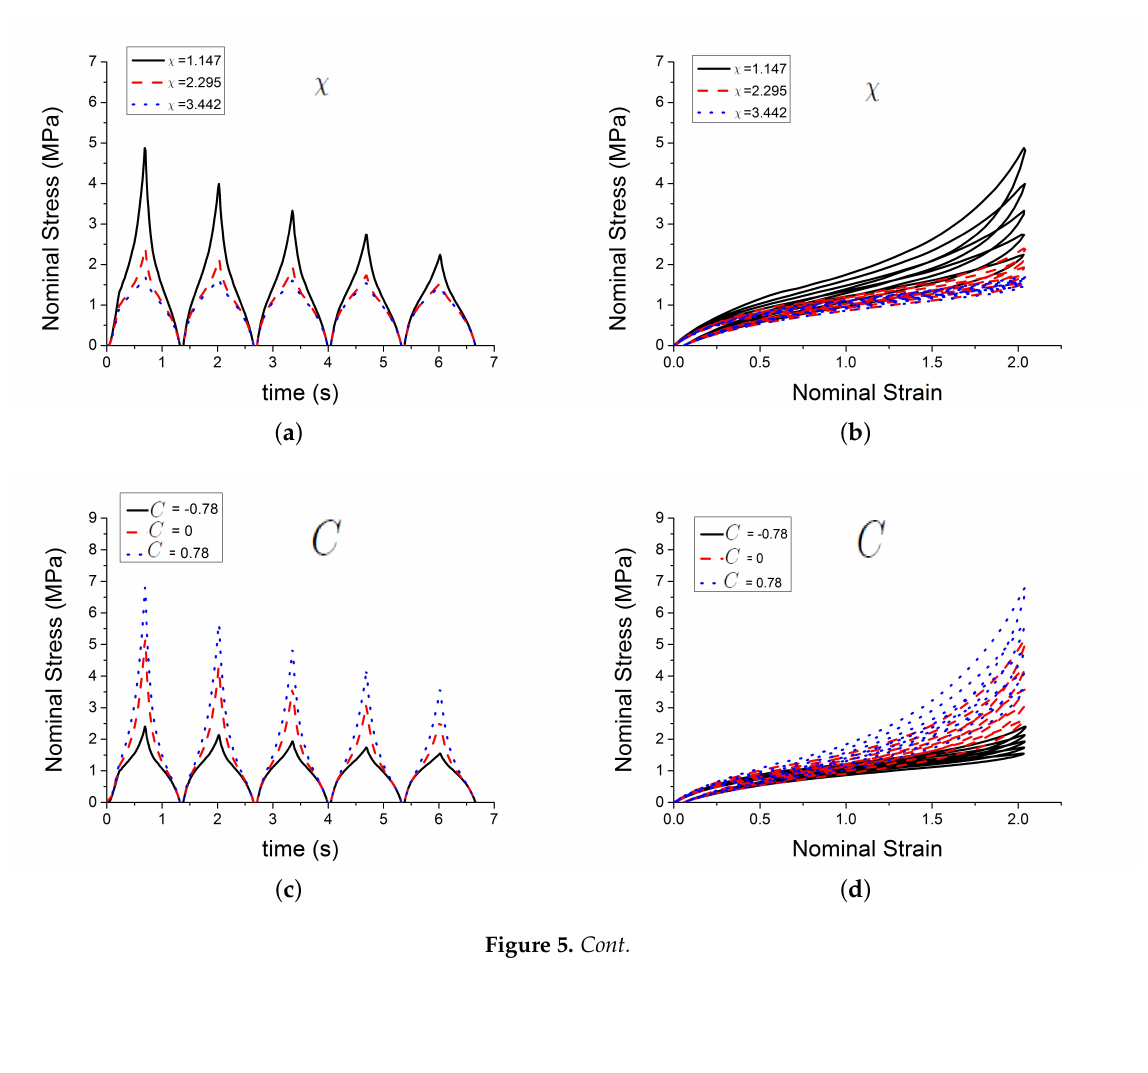
Figure 4. Influence of parameters. ( a , b ) show the effect of the parameter G c ; ( c , d ) show the effect of the parameter G e ; ( e , f ) show the effect of the parameter X max,0 .